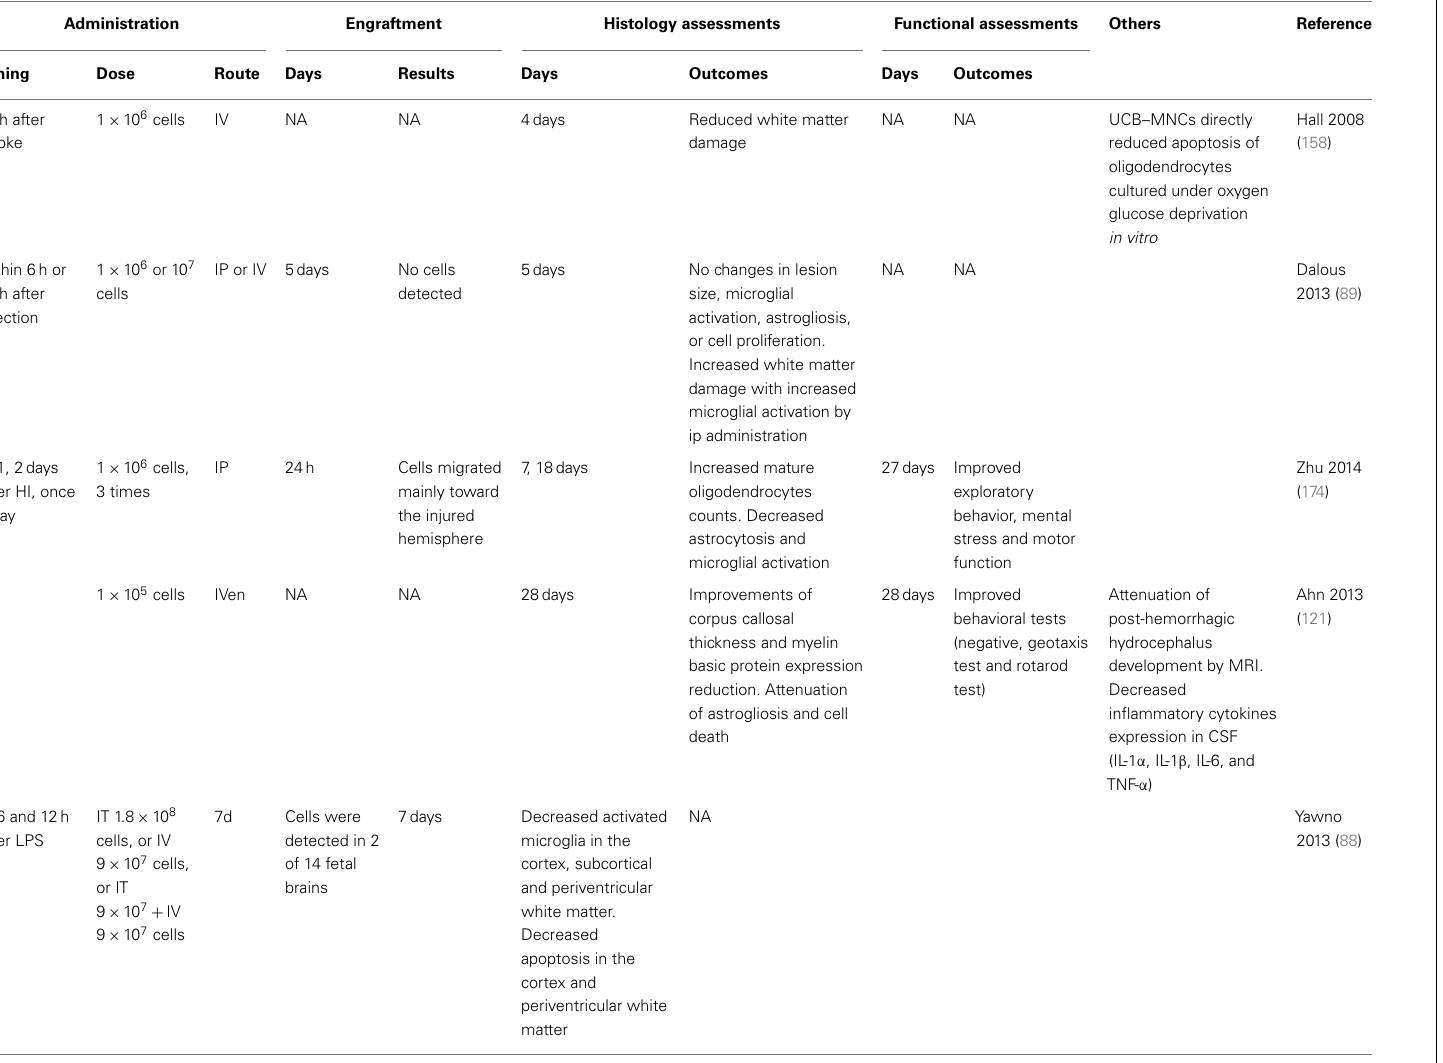
Table 2 | Outcome of cell-based interventions in preterm brain injury